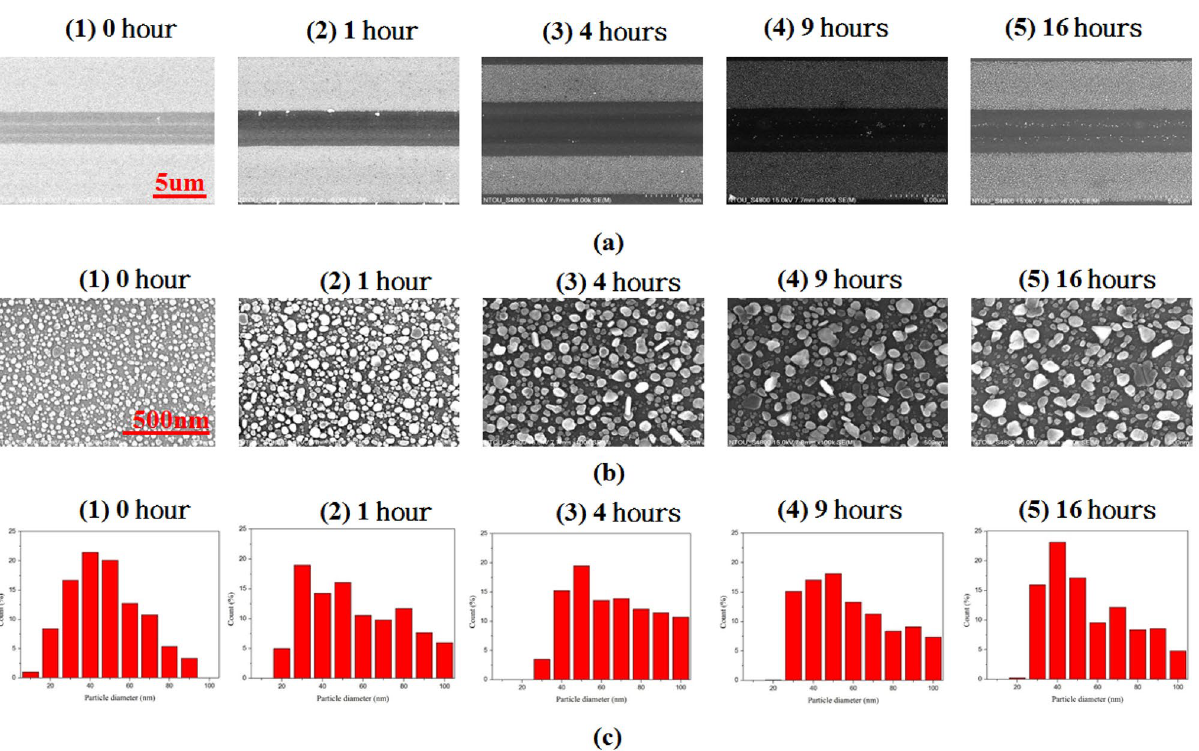
Figure 3. Scanning electron microscopy (SEM) images of photoreduced AgNPs using PPE LiNbO 3 substrates made with different annealing time, ( a ) with the magnification of 6 K and ( b ) with the magnification of 100 K, respectively. ( c ) Size-distribution histogram of the fabricated PPE LiNbO 3 substrates under different annealing times of 0, 1, 4, 9, and 16